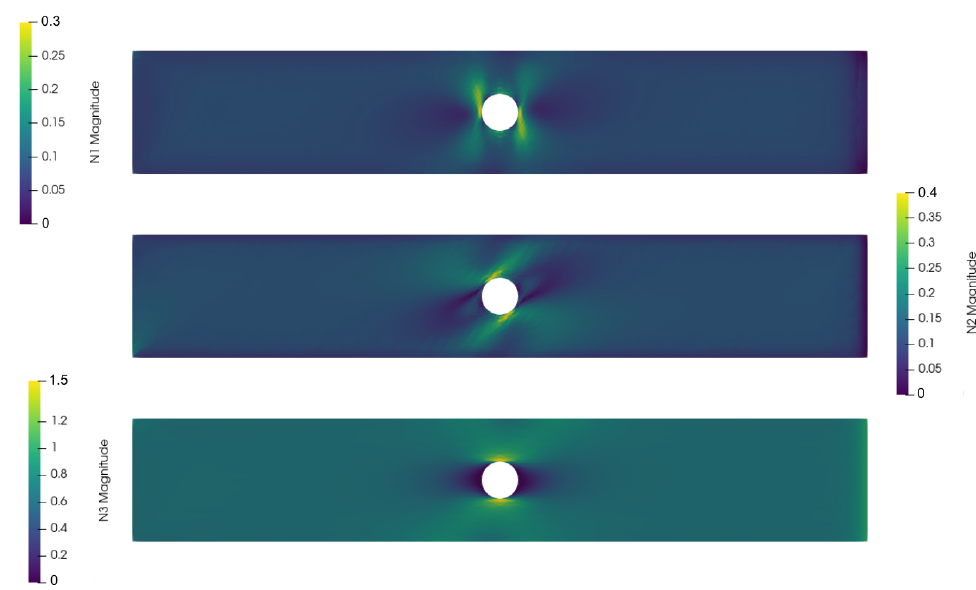
(cid:113) N αβ N αβ [MPa/m] in layers 1, 2, and 3.